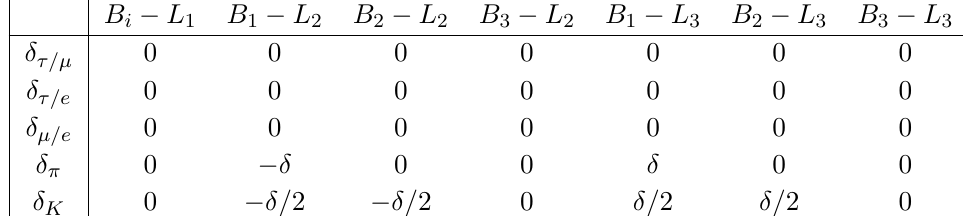
(cid:17) ( g ‘ =g ‘ 0 ) (cid:0) 1 and (cid:14) (cid:25);K (cid:17) ( g (cid:28) =g (cid:22) ) (cid:25);K (cid:0) ‘=‘ 0